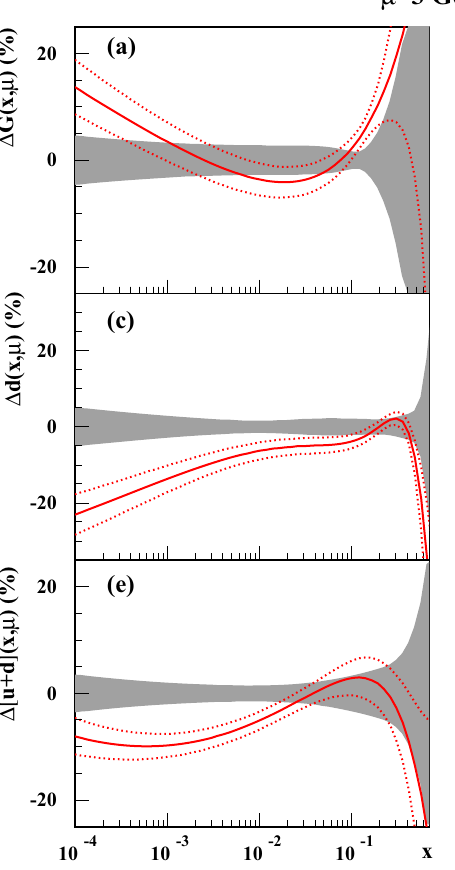
Fig. 1 The 1 σ band for the n f = 3 flavor NNLO ABM16 PDFs [4] for a gluon, b up-quarks c down-quarks d the symmetrized strange sea and e the non-strange sea, at the scale of μ = 3 GeV versus x (shaded